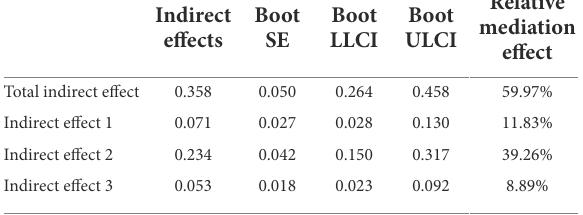
TABLE 3 Teacher efficacy and self-leadership in the mediation effect